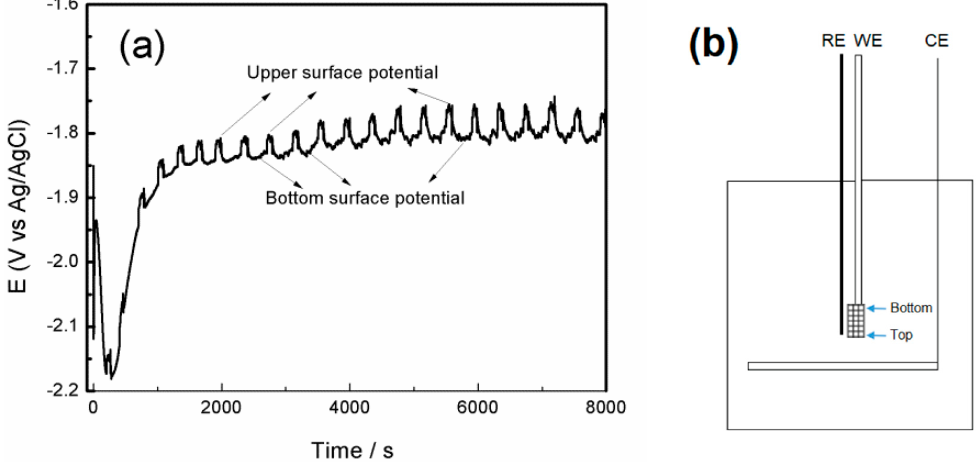
Figure 2. ( a ) Voltage against time curves measured with micro-reference electrode placed at bottom surface and top surface of SLM-Ti scaffolds and ( b ) description of potential measurement point.